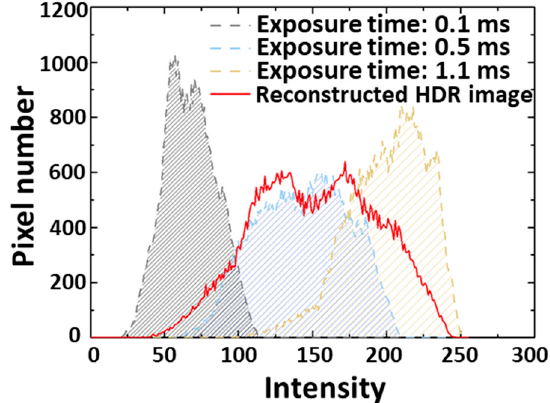
Figure 7. The corresponding histogram measured from images before and after image reconstruc ‐ tion. The area of HDR image histogram is increased by 1.36 times compared with the single expo ‐ sure image (0.5 ms).